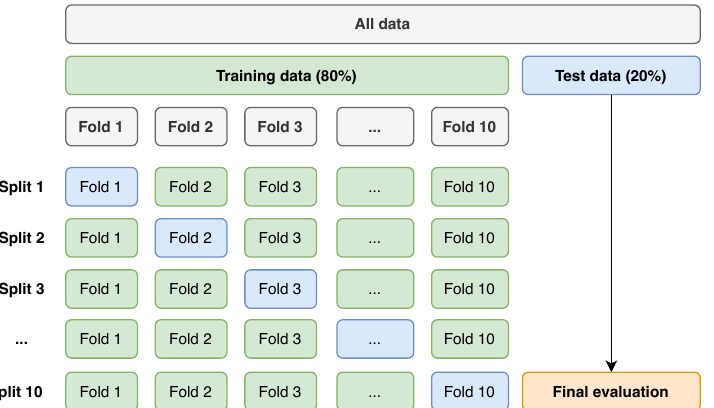
Figure 6. Data division strategy. Adapted from: https://scikit-learn.org/stable/modules/cross_ validation.html (accessed on 17 January